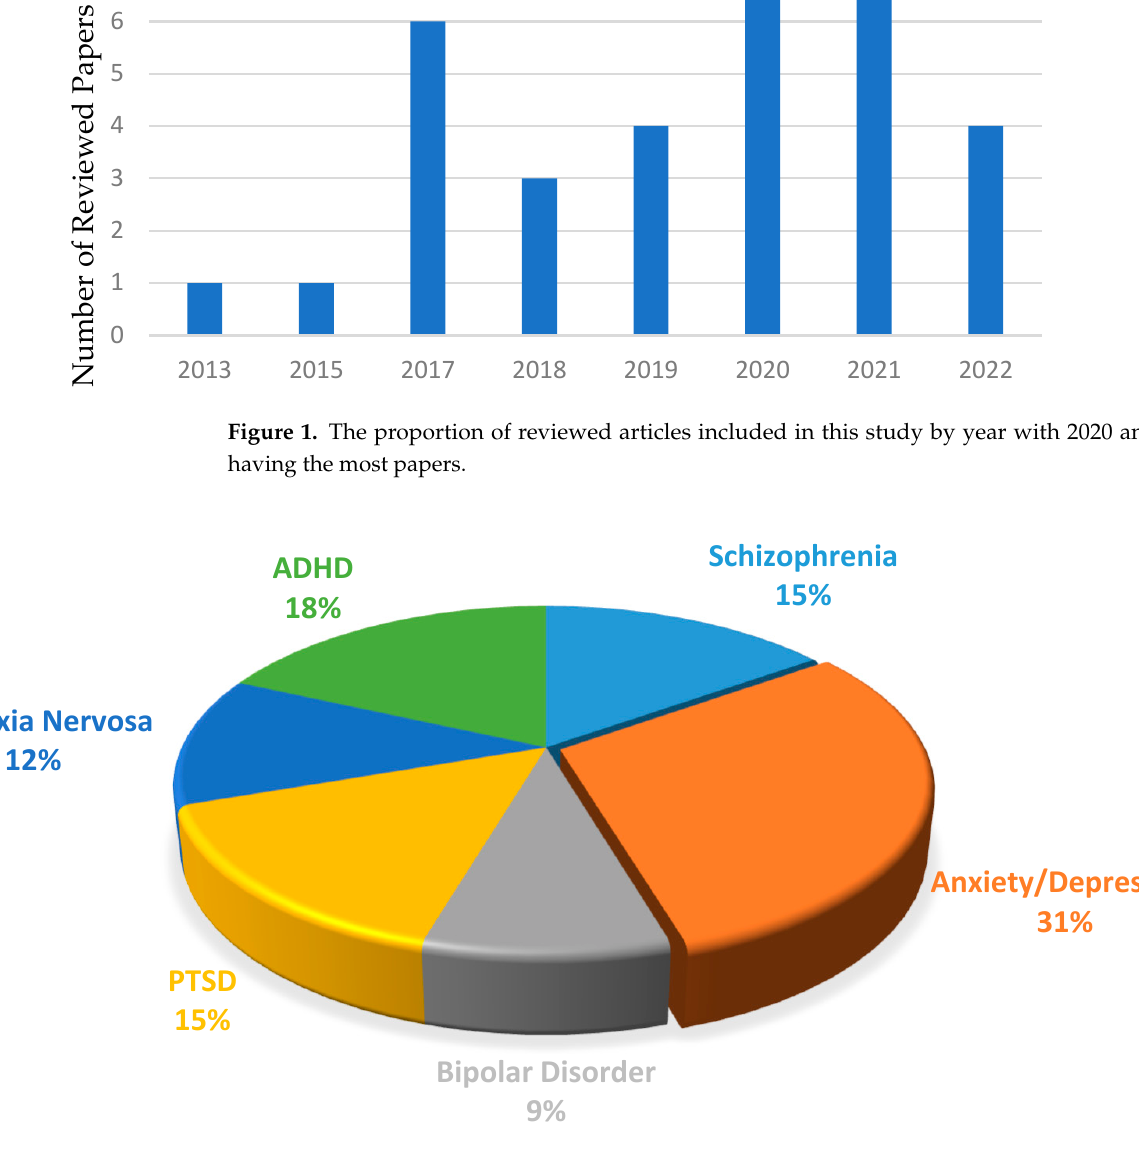
Figure 2. Percentage of all articles for each mental disorder included in this study.